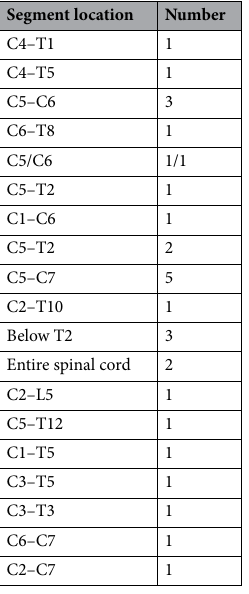
Figure 1. ( A ) MRI image at sagittal plane on T2W, ( B ) the ratio as index of syrinx dimension which was calculated by maximal syrinx diameter (S)/spinal cord diameter ( C ) at the same location on T2W axial. ( C ) Location map and measurement of DTI parameters on sagittal plane. ( D – F ) Measurement of DTI parameters on transverse plane. Segment